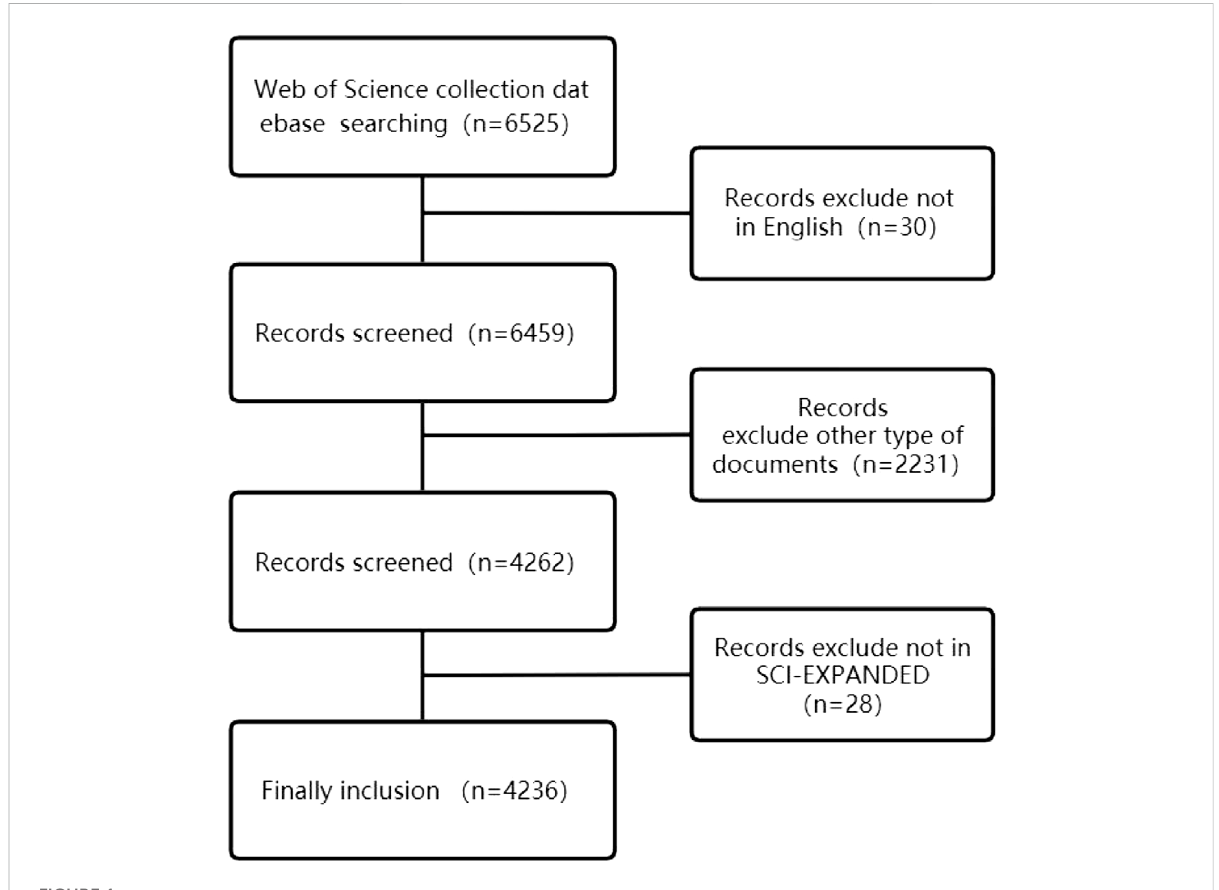
FIGURE 1 Flowchart of literature